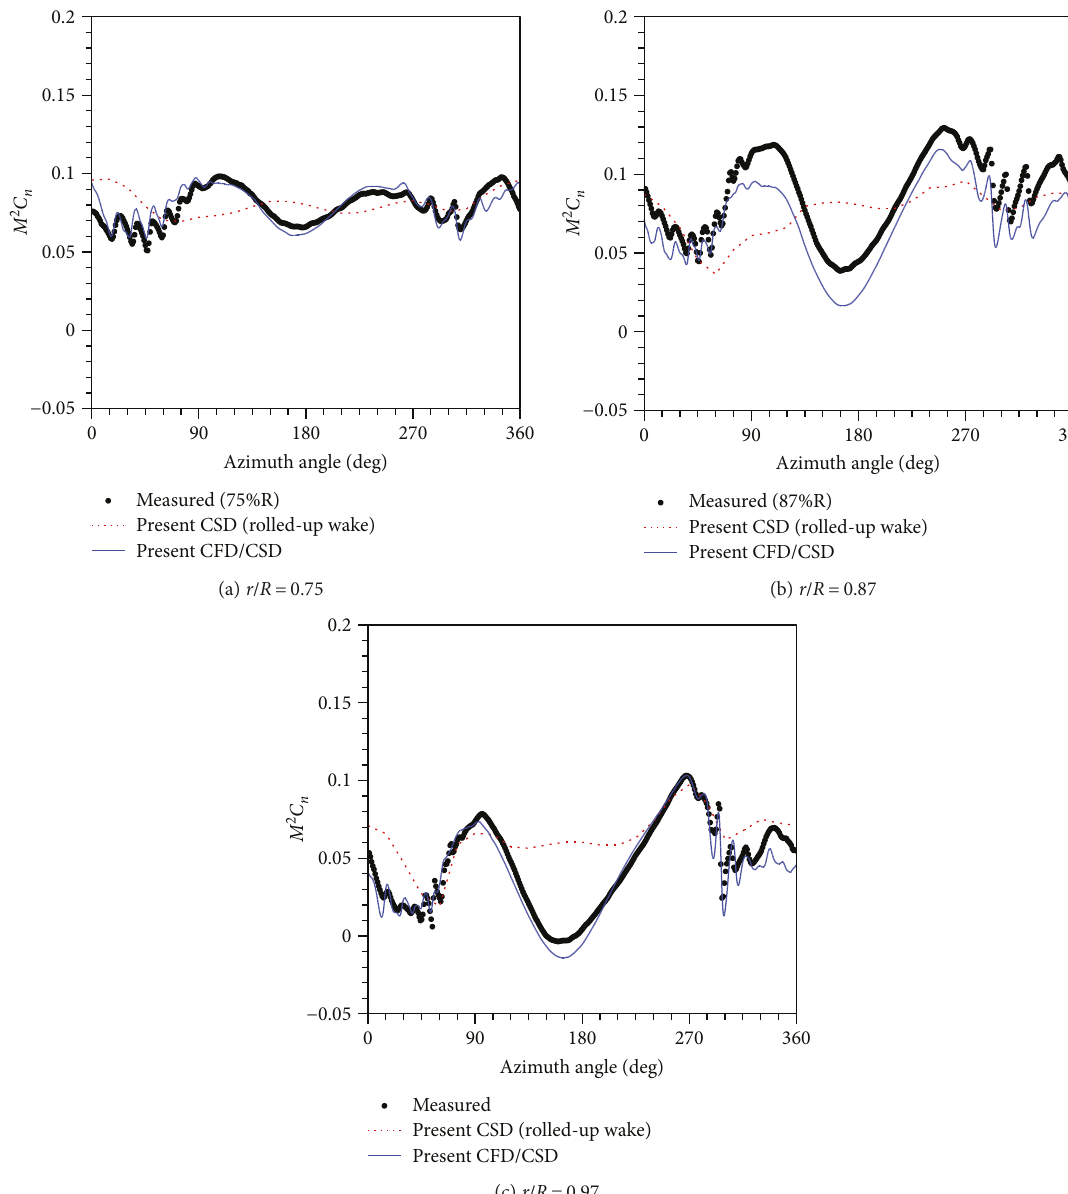
Figure 13: Correlation of section normal forces M 2 C